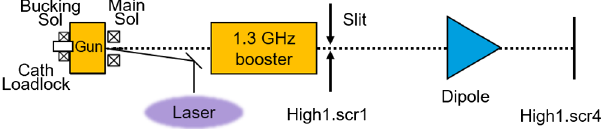
FIG. 3. Schematic plot of the projected emittance measurement beamline at PITZ, High1.scr1, and High1.scr4 are two screen stations for slit-scan emittance measurements. The slit is installed at High1.scr1 and beamlet images are measured at High1.scr4. A dipole magnet is for beam energy